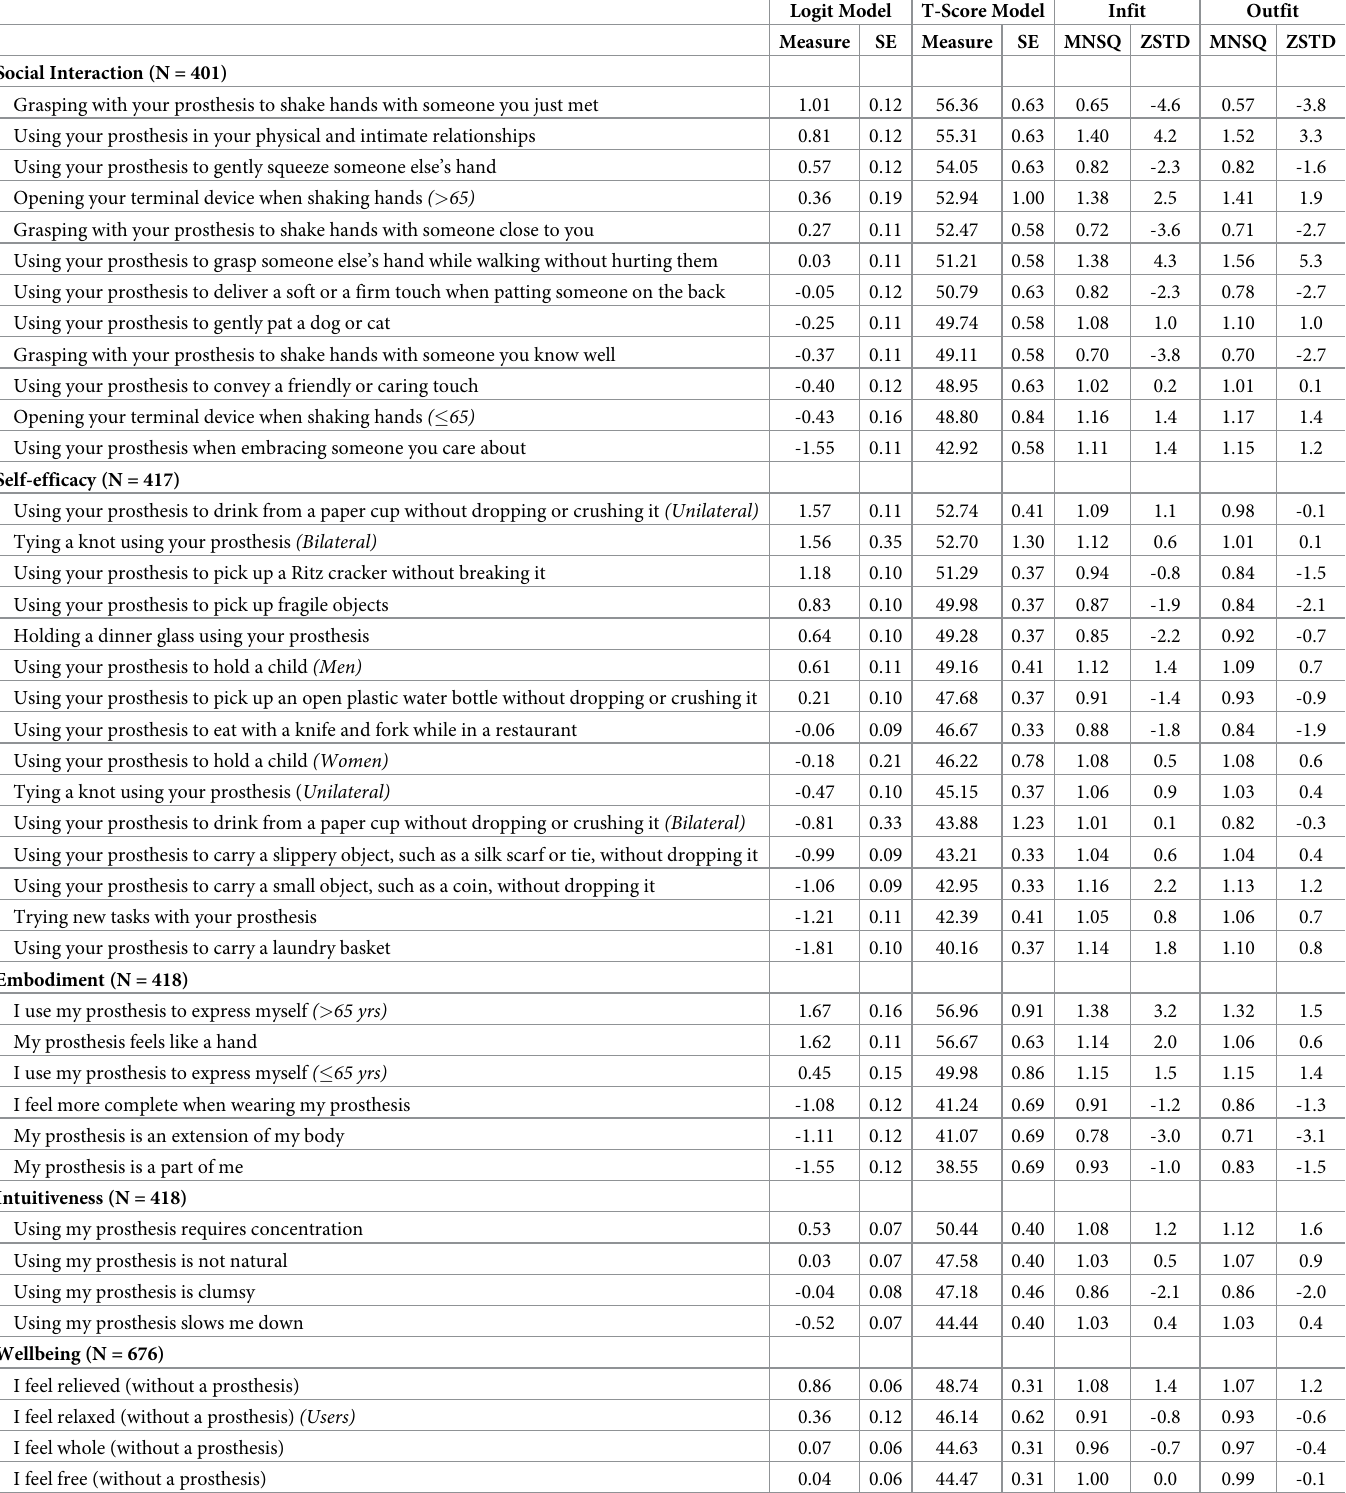
Table 5. Partial credit model of PEM